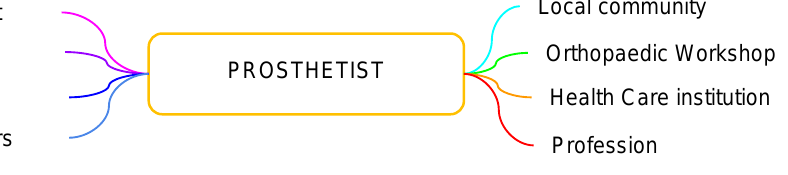
Figure 1: Centering of prosthetist in